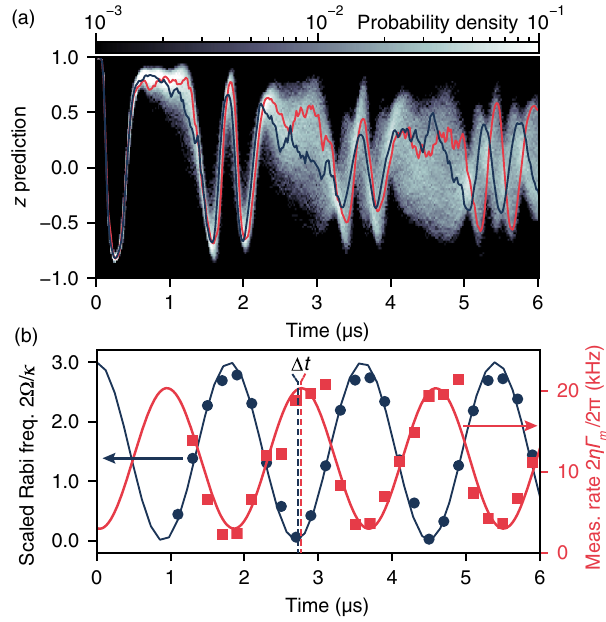
FIG. 5. Uncovering hidden time dependencies from trajectories subject to sinusoidal Rabi drive modulation. (a) A histogram of the reconstructed z coordinate shows periods of increased and decreased diffusion, also visible in two sample trajectories (red and blue). (b) Repeated analysis of the LSTM trajectories for successive 0.2- μ s-long time windows. For each window we extract the instantaneous Rabi frequency and measurement rate by fitting the average drift to Eqs. (6) and (7) and diffusion to Eqs. (8) and (9), respectively. The extracted measurement rate 2 η Γ = 2 π (red squares) shows maxima during periods of large m diffusion in (a). The solid red line is a simple sinusoidal fit to the red squares. The instantaneous Rabi frequencies (blue dots), obtained from fitting trajectories to the Lindbladian part of the reduced qubit master equation, are consistent with the applied drive amplitude (solid blue line). Fit results for t < 1 μ s are not shown, since early during the evolution trajectories have not spread sufficiently for accurate fit